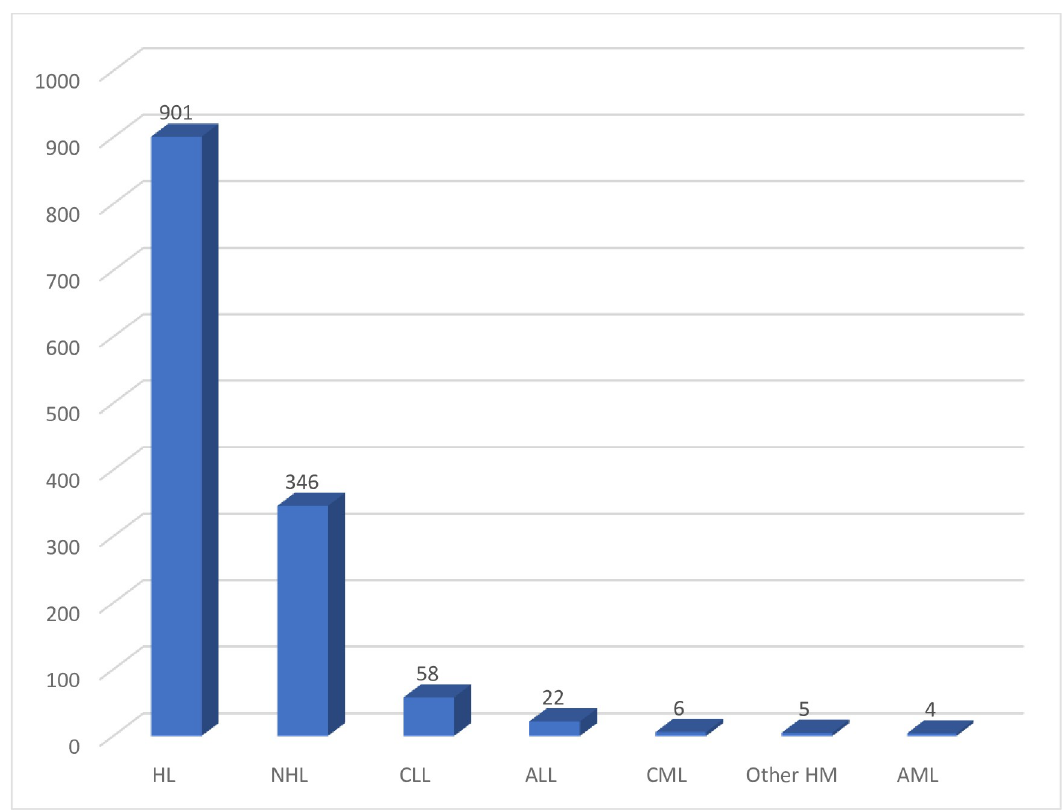
Fig 1. Hematological malignancy among study participants at UoG-CSH and Bahir-Dar Felegehiwot comprehensive specialized hospital: Northwest Ethiopia.